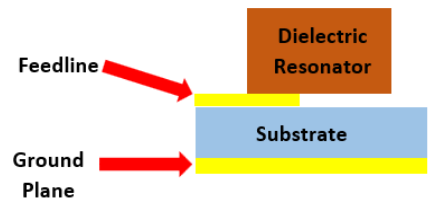
Figure 3. Typical configuration of DRA.